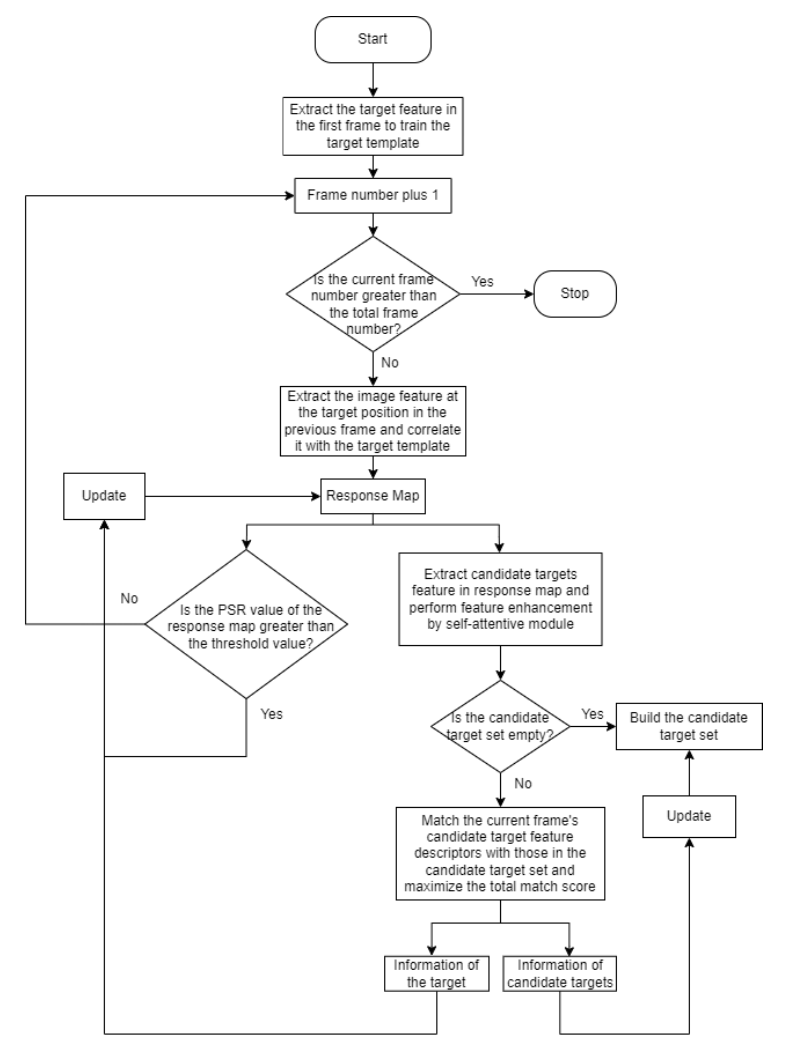
Figure 5. Algorithm flow